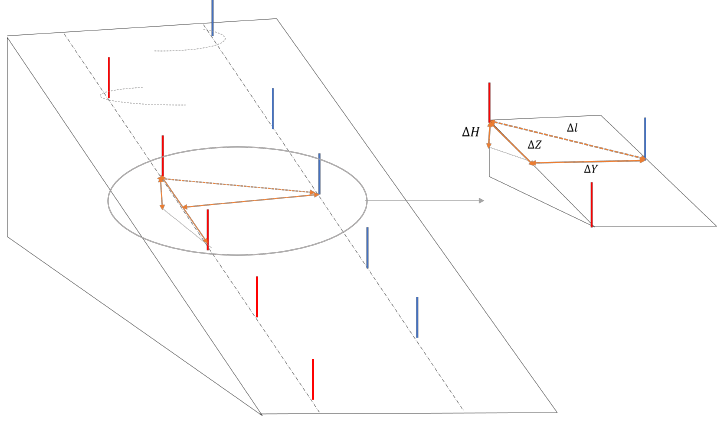
Figure 13. Slope inclination measures.